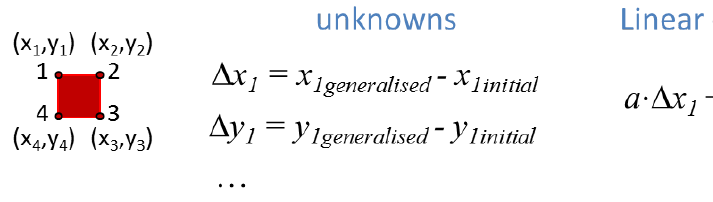
Figure 3. How to translate generalization into a linear equation